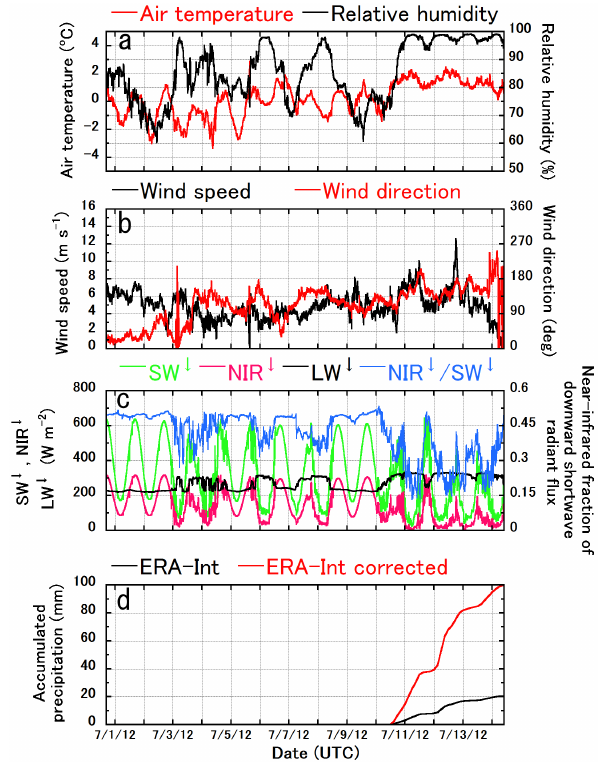
Figure 2. Meteorological conditions measured at SIGMA-A during the IOP (30 June to 14 July 2012): (a) air temperature and rela- tive humidity with respect to water observed at a nominal height of 3.0m above the snow surface; (b) wind speed and direction ob- served at 3.0m above the snow surface on 29 June 2012 (wind di- rection is denoted in degrees that indicate the direction from which the wind is blowing; the degrees increase from 0 to 360 as the di- rection is rotated clockwise from north); (c) downward shortwave (SW ↓ ), near-infrared (NIR ↓ ), long-wave (LW ↓ ) radiant fluxes, and the near-infrared fraction of the SW ↓ ; and (d) accumulated precip- itation obtained from 3-hourly ERA-Interim reanalysis data (ERA- Int), where the black line denotes the original amount of precipita- tion and the red line reflects the correction based on in situ mea- surements of accumulated precipitation measured during the period from 20:00UTC on 12 July 2012 to 11:00UTC on 14 July